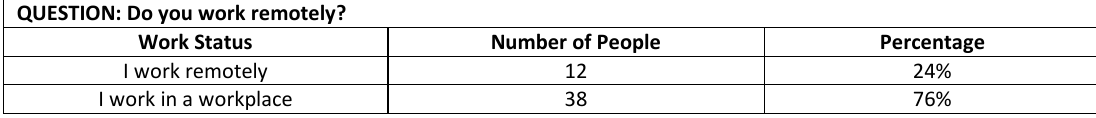
Table 6 Distribution of users who work remotely and in a